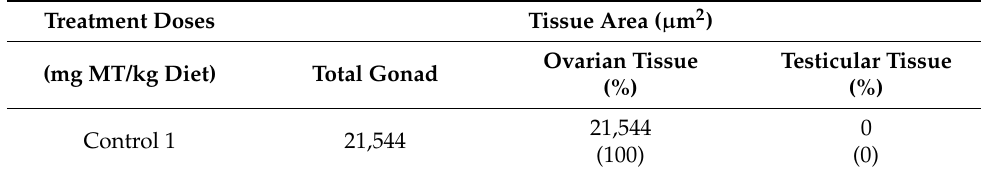
Table 1. Total gonad and testicular tissue areas of RG females treated with MT for a 50-day period ( n = 1